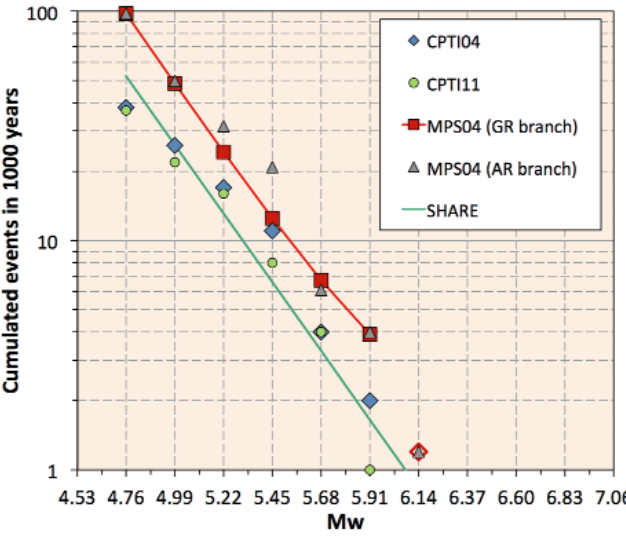
Figure 3. Comparison between the cumulative number of earthquakes in the CPTI04 and CPTI11 catalogs and the seismicity rates for the GR and AR branches of MPS04 and for the SHARE project (as available on July 2012) for seismic source zone 912. All rates are normalized to 1000